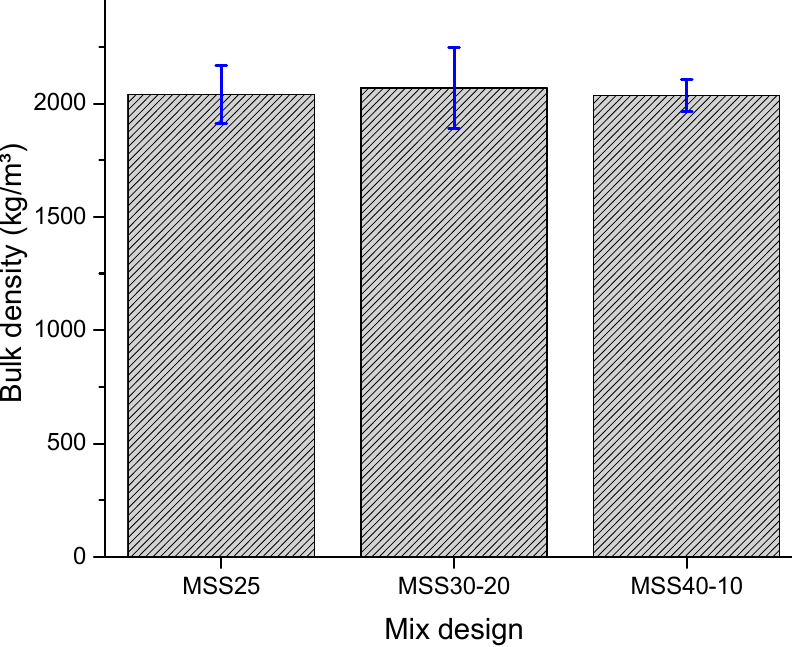
Figure 3. Bulk density of fresh mortars.